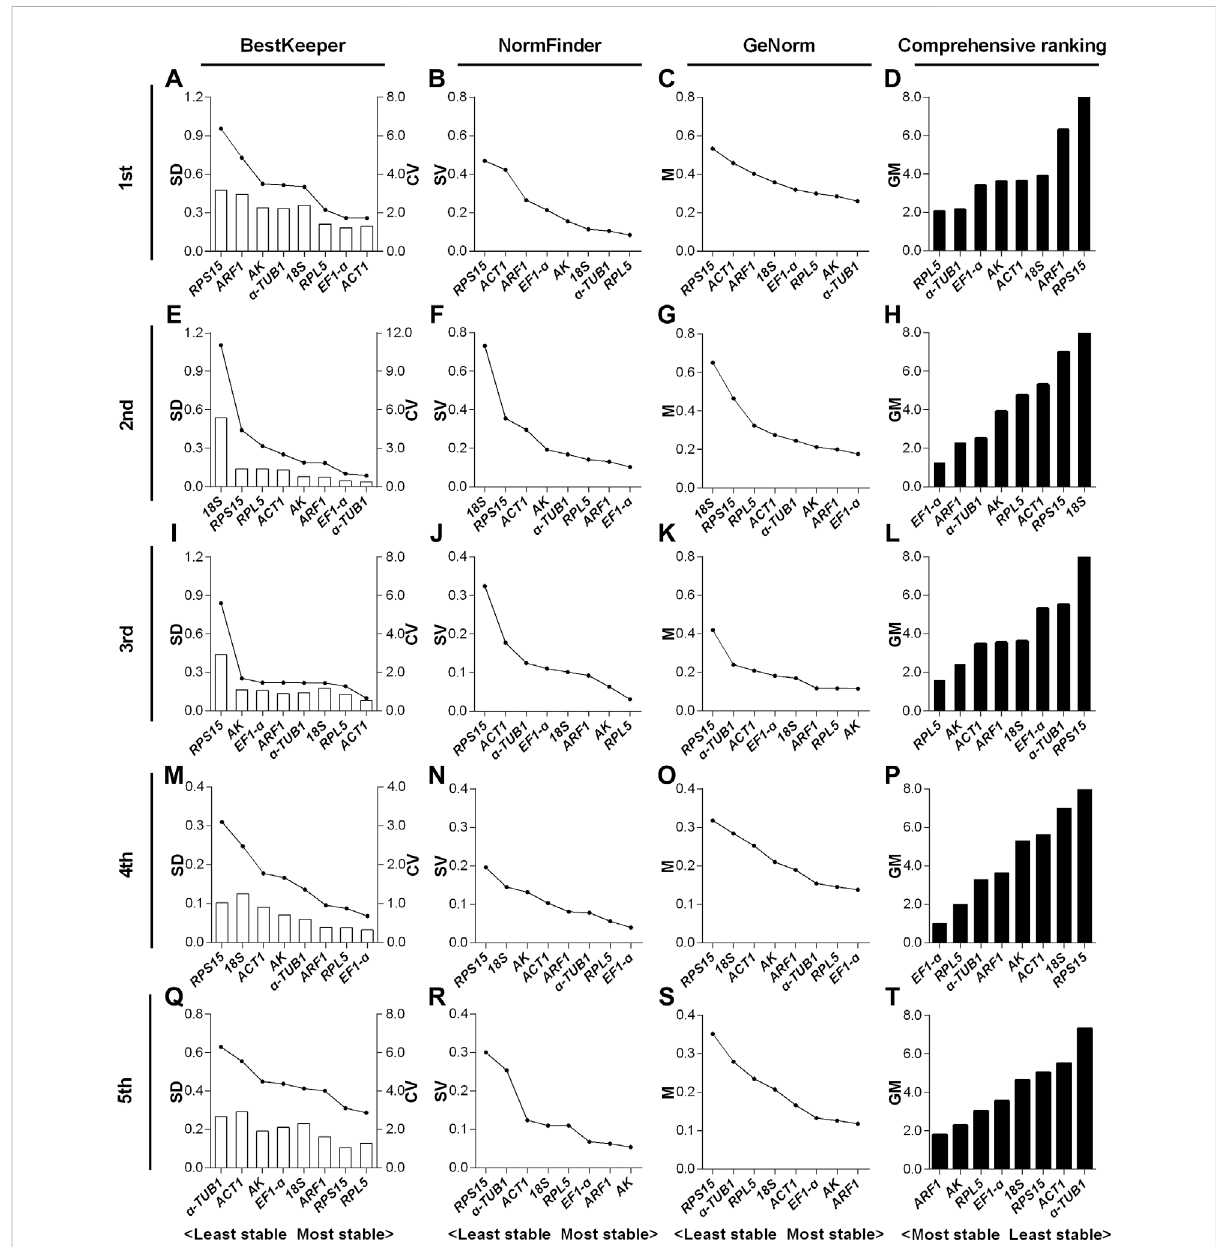
FIGURE 3 Expression stability evaluation of candidate reference genes respectively for 1st to 5th instar nymphs of N. lugens by BestKeeper, NormFinder, GeNorm and comprehensive analyses. Each row of the panel indicates that the experimental samples are respectively from 1st (A – D) , 2 nd (E – H) , 3rd (I – L) , 4th (M – P) and 5th (Q – T) instar nymphs under the hypomagnetic fi eld versus local geomagnetic fi eld. The standard deviation (SD) and coef fi cient of variation (CV) were given by BestKeeper (A , E , I , M , Q) . The stability value (SV) was given by NormFinder (B , F , J , N , R) . The average expression stability (M) was given by GeNorm (C , G , K , O , S) . The comprehensive ranking was further generated based on the results derived from the geometric mean (GM) of these three algorithms (D , H , L , P , T) . Stable reference genes generally have lower SD, SV, M and GM